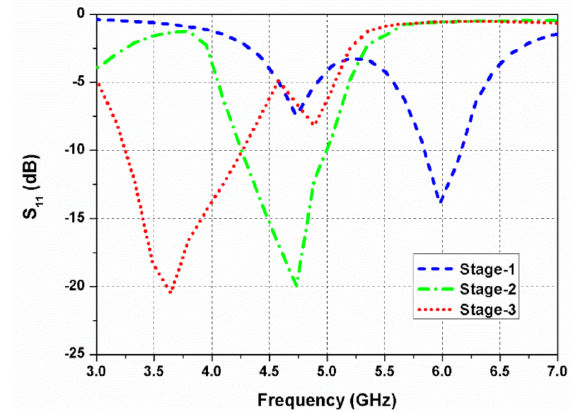
Figure 3. Simulated reflection coefficients of the evolution steps.